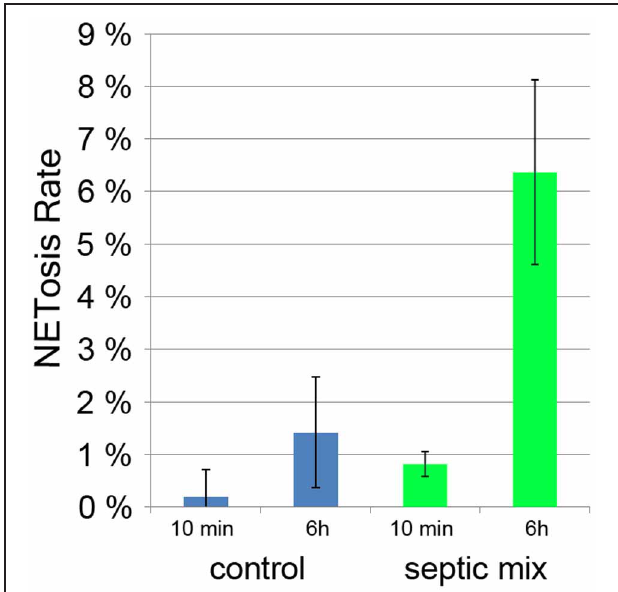
FIGURE 7 | NETosis rate of neutrophils treated for 10min and 6h for with proinflammatory cytokines (TNF- α , G-CSF, and IL-1 β ).